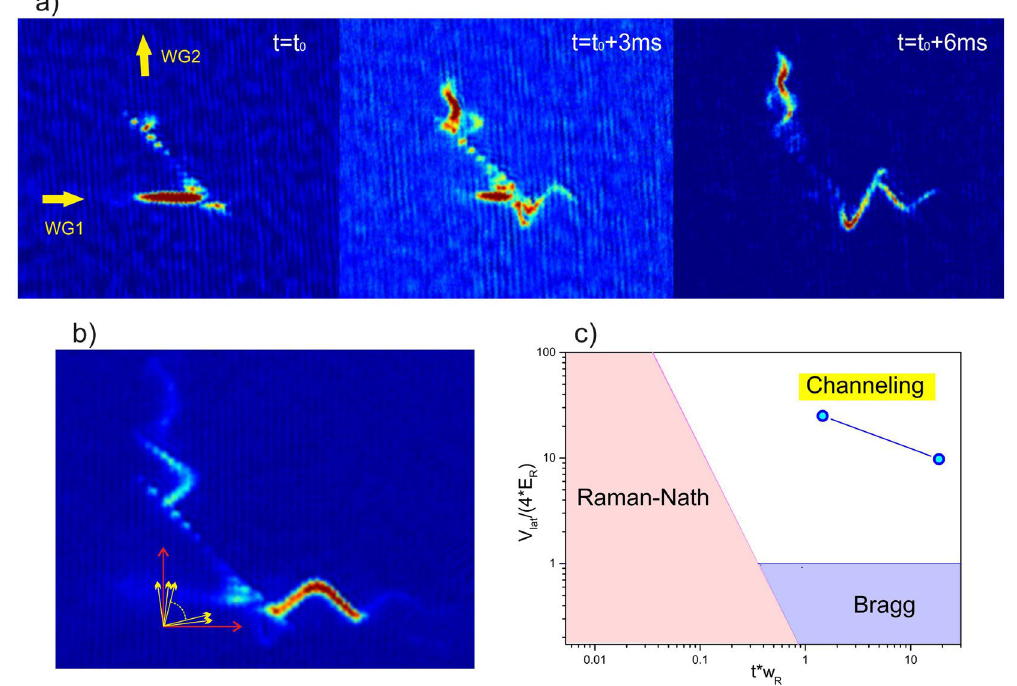
Figure 5. ( a ) Atomic clouds imaged at different times when passing through the quasi-Bragg splitter and after 5 ms time-of-flight. The BEC velocity before entering the reflector is (7.0 ± 0.2)v R , the height of the lattice is = 40 ms is the time the BEC takes to move from its initial position to the splitter. The population ε = . 0 92 , and t 0 of several quasi-momentum peaks is visible around q 1,2 signalling the presence of multi-photon processes in the interaction with the strong lattice. The quasi-momentum distribution also provides an effective ruler for the understanding of the momentum distribution of the atoms when leaving the splitter. For the measurements shown here, for example, one can see that the reflected and transmitted atoms occupy a few different momentum states after the splitting. ( b ) For high enough initial velocities, two main momentum states can be occupied in the exit ports of the splitter. The picture shows a measurement taken for v = (8.1 ± 0.2)v R at t = 40 ms with ε = . 1 0 . ( c ) Our beam splitter lies between the Bragg and the “channeling” regime for the velocity range that we have investigated, i.e. 3v R ≤ v ≤ 8v R . However, thanks to the smooth Gaussian envelope of the lattice, the diffraction pattern produced by a single spatial gap is very similar to that typical of a Bragg regime. We refer to this regime as quasi-Bragg